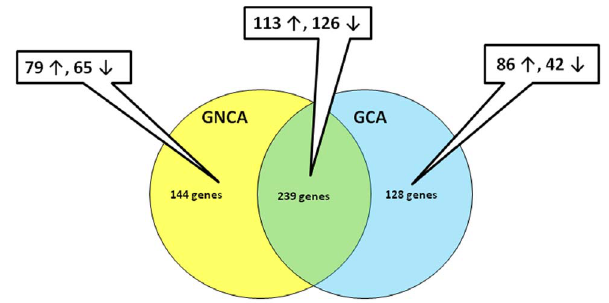
Figure 4. Diagram showing the number of significantly dysregulated genes (GCA only, GNCA only, and common to